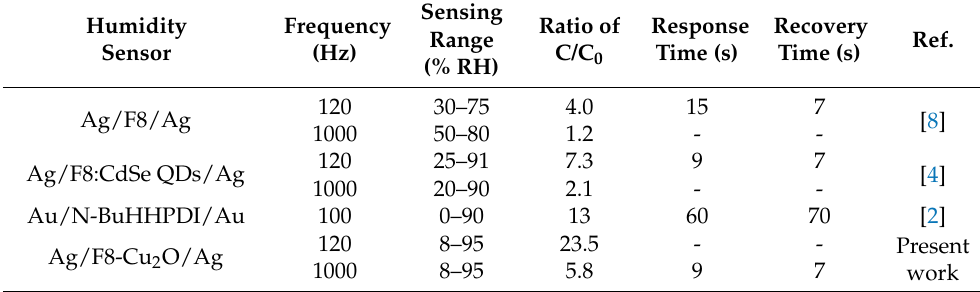
Table 2. Comparison of the humidity sensor’s parameters with previous